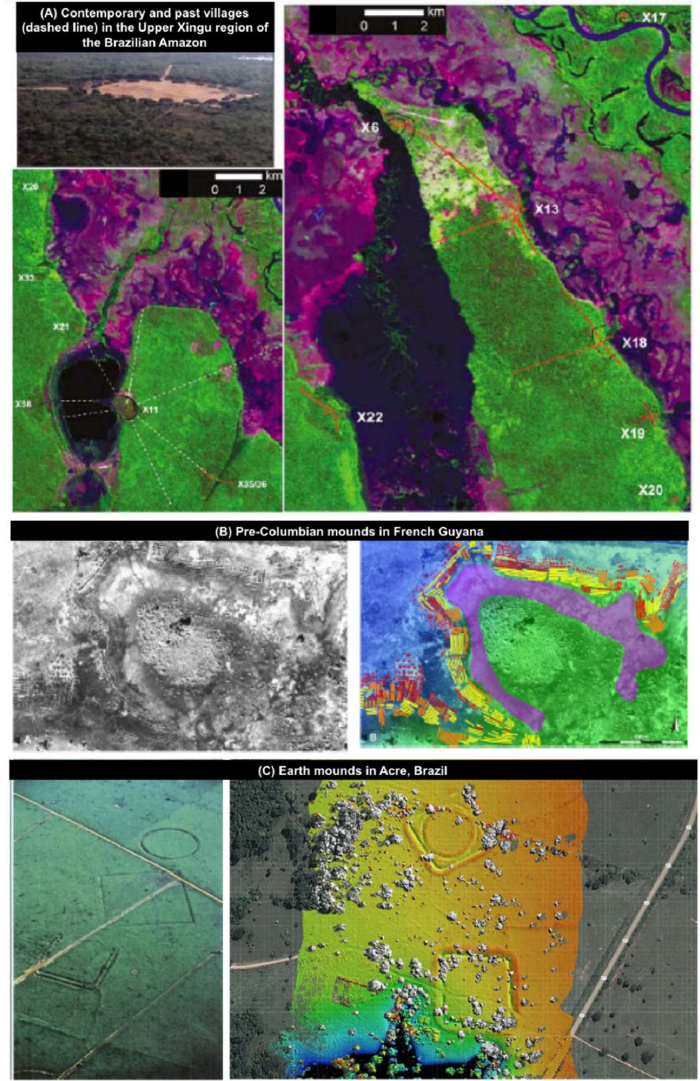
Figure 1. Examples of RS-enabled detection of pre-historic human activity in Mid-American tropical landscapes: ( A ) Contemporary and past villages (dashed line) in the Upper Xingu region of the Brazilian Amazon (dashed lines represent past villages, red lines represent known ancient roads and black lines represent ditches; adapted from [45]), ( B ) Pre-Columbian mounds as interpreted using photo and spectroscopic imagery (adapted from [18]), ( C ) earth mounds in Acre, Brazil, first exposed by deforestation (left panel adapted from [16]), then using LiDAR technology (right panel; ([21],